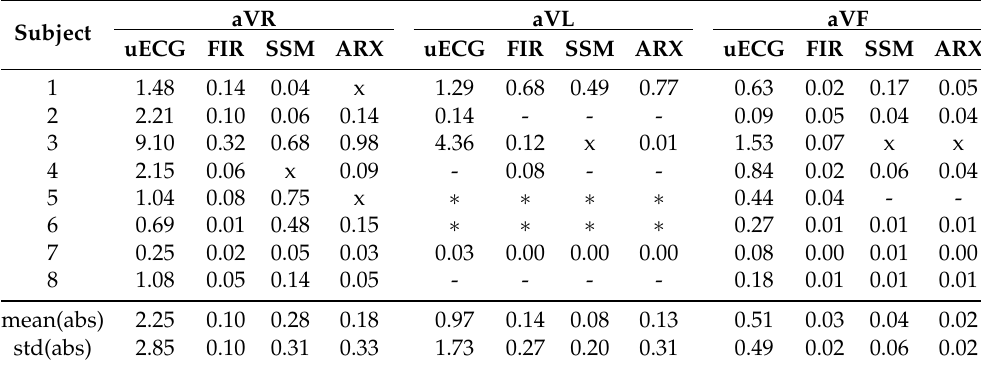
Table 4. Mean square error for the amplitude deviation of the